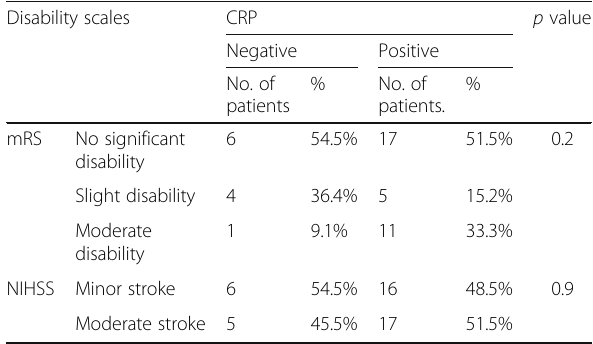
Table 4 Comparison of CRP level in different disability scales Disability scales CRP p